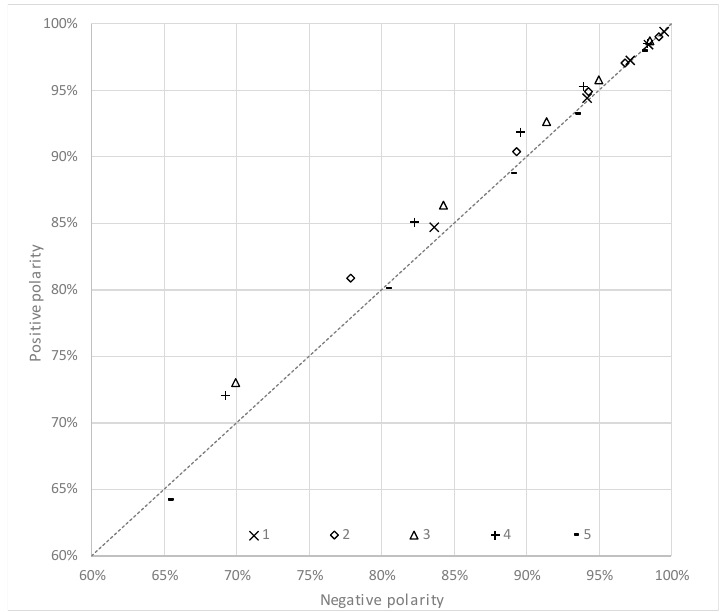
Figure 10. Product PSD after a different number of pulses (feed monosize 5000/3350 µm) and different polarity.